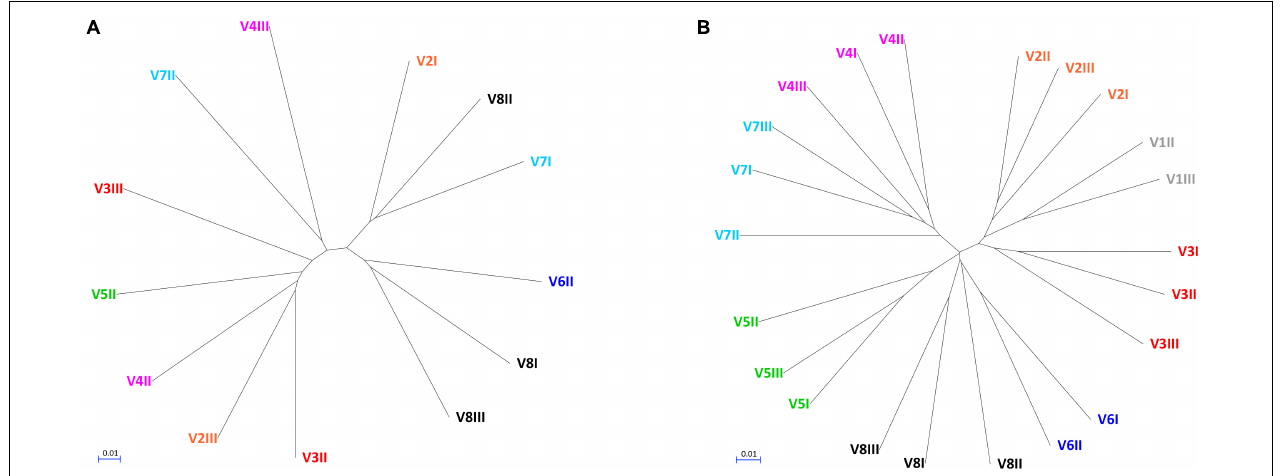
FIGURE 2 | UPGMA cladograms of fungal (A) and bacterial (B) communities, constructed using the corresponding Jaccard distance matrices.